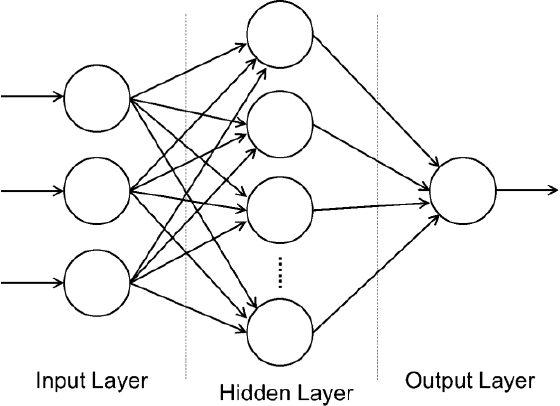
Figure 1. Schematic diagram of a two-layer feedforward network . Table 4 . Input variable, target, and output layers in ANN training.